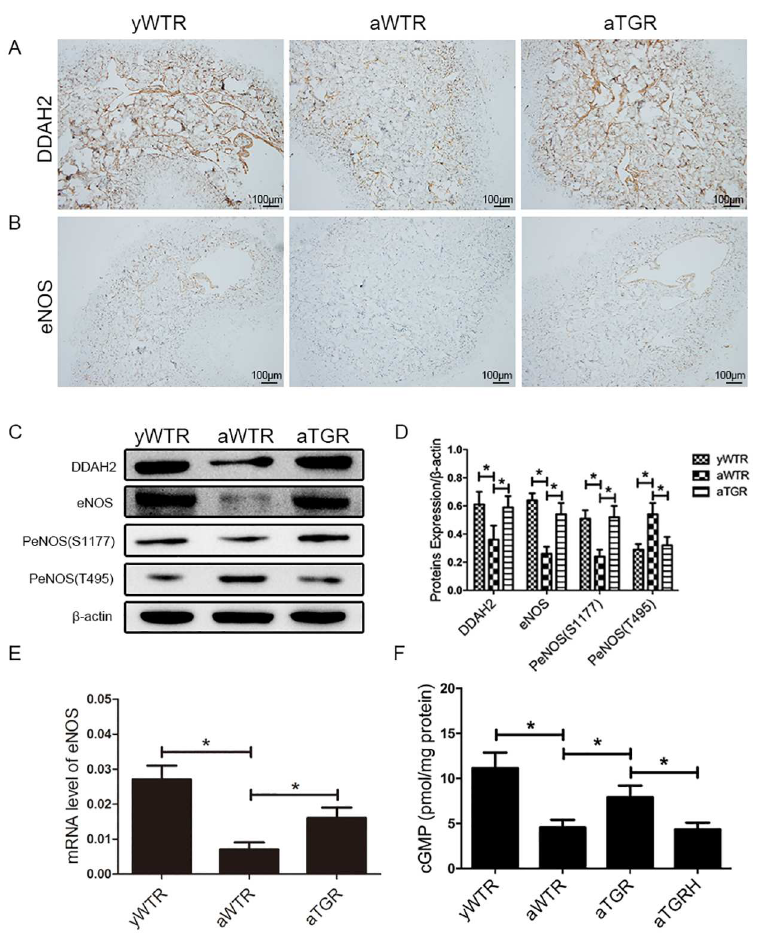
Fig 4. Expression levels of DDAH2, eNOS and cGMP. (A) and (B): Immunohistochemistry results of expressions of DDAH2 and eNOS (magnification × 100). (C) Representative western blot results of DDAH2, eNOS, P-eNOS (T495) and P-eNOS (S1177)in corpus cavernosumof all three groups. (D): Expressions of DDAH2, eNOS, P-eNOS (T495) and P-eNOS (S1177)with β -actinas the loadingcontrol in the corpus cavernosumof three groups were presentedthrough bar graphs. (E): eNOS expressionlevel in corpus cavernosumof rats in all groups by real—time RT-PCR using the 2- Δ Ct method. (F): cGMP concentrations of all groups assessedby ELISA method. The data are expressedas mean ± s.d. * P < 0.05when comparing the two groups under each end of the